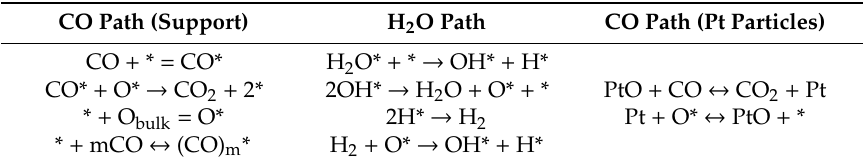
Figure 19. In situ (diffuse reflectance infrared fourier transform spectroscopy) DRIFTS spectra at 250 °C on Pt/CeO 2 ( a ); Pt/Ce 0.75 Zr 0.25 O 2 ( b ); Pt/Ce 0.50 Zr 0.50 ( c ); Pt/Ce 0.25 Zr 0.75 O 2 ( d ); Pt/ZrO 2 ( e ) (5% CO + 10% H 2 O in N 2 ; Wcat = 50 mg; P = 101.3 kPa; Fv = 60 mL·min − 1 ), reproduced from [122], with permission from Elsevier, 2011. Table 7. WGS mechanism on Pt / CeO 2 –ZrO 2 (-La 2 O 3